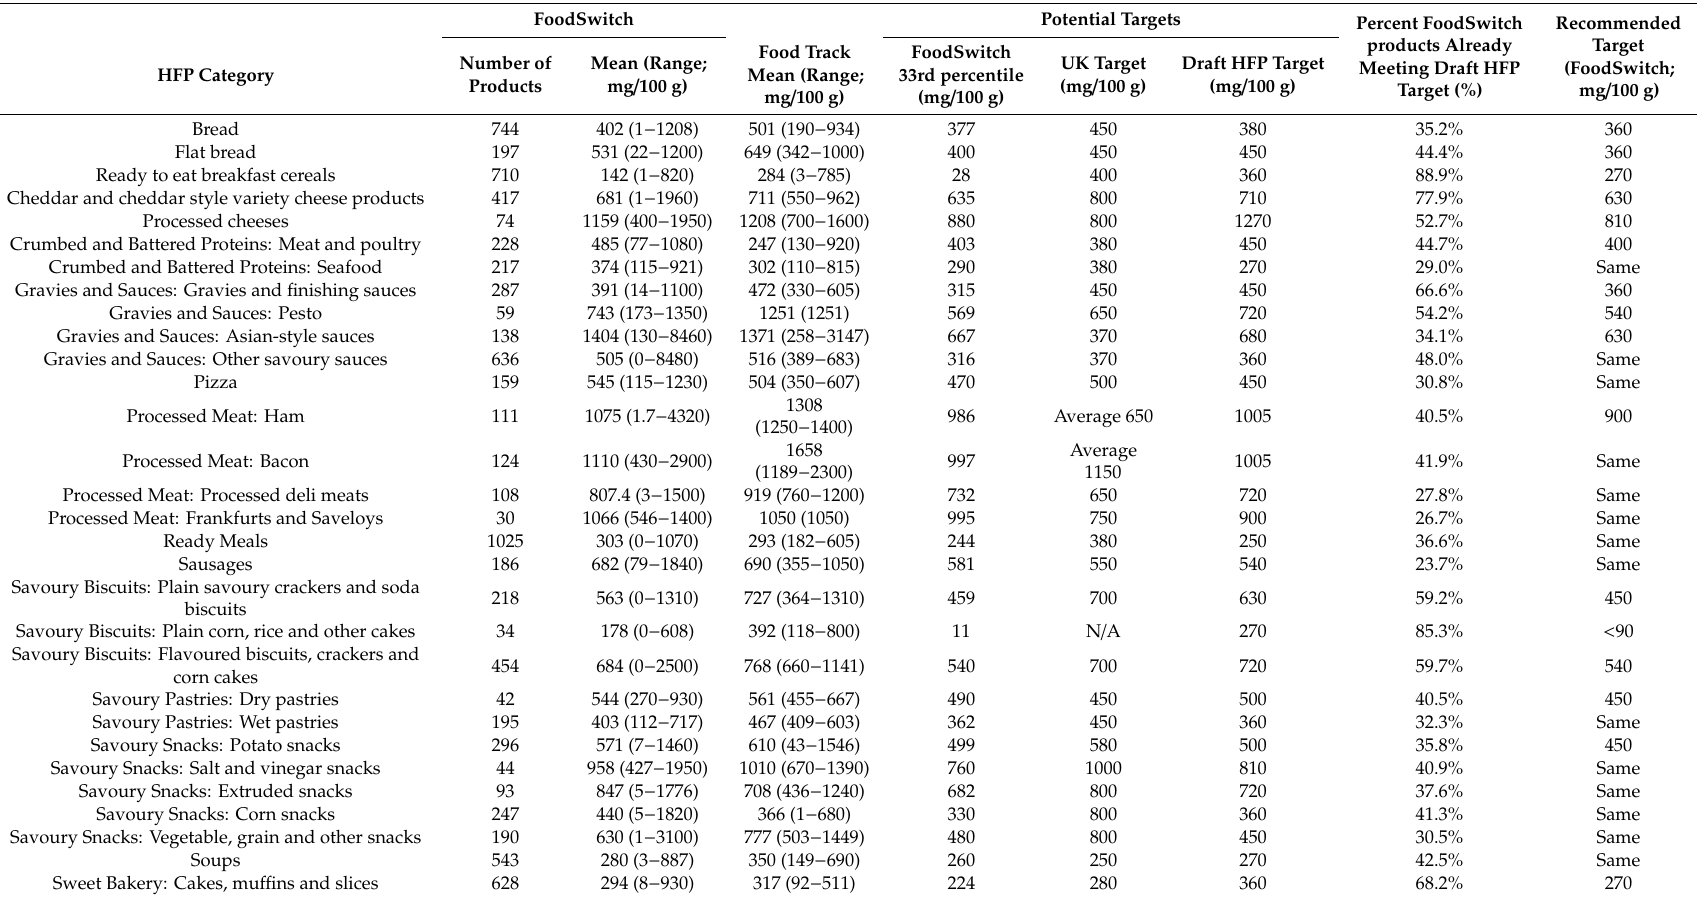
Table 1. Sodium levels of products included the FoodSwitch and FoodTrack databases, potential reformulation targets, and recommended targets based on FoodSwitch